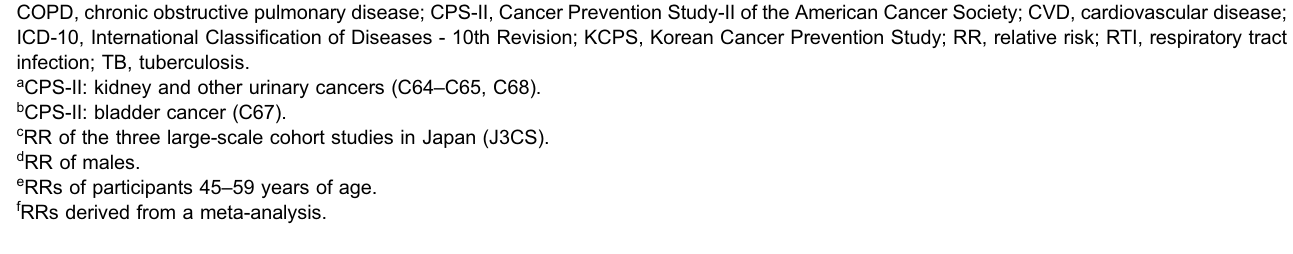
Disease (ICD-10 code)